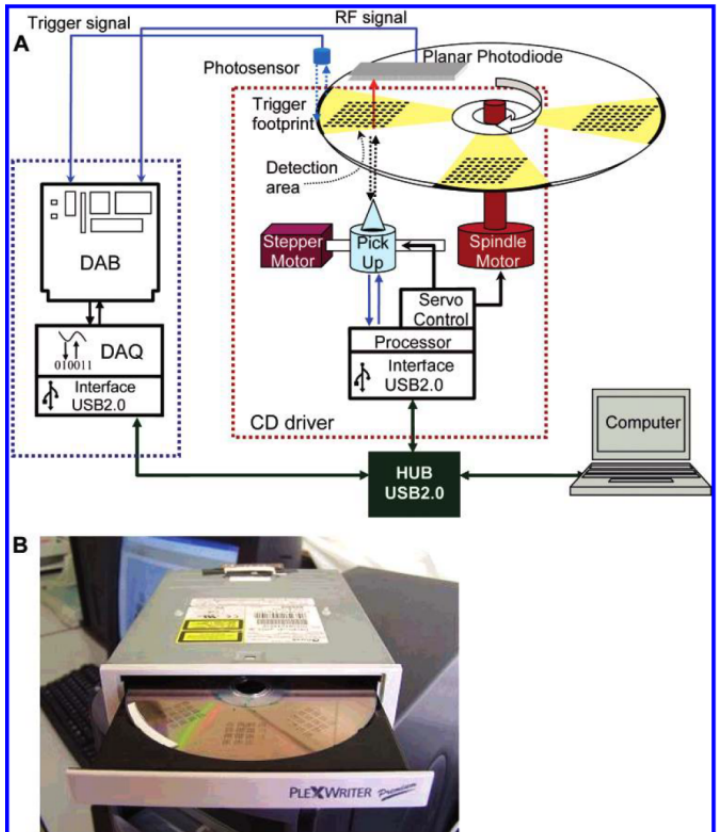
Figure 2. ( A ) Schematic representation of the detection system. In the blue dashed outline: DAB, DAQ and mMachine interface, and in the red dashed outline: CD drive system, power section and processor; ( B ) Picture of the CD player used in this work (modified from [63] © 2007 American Chemical